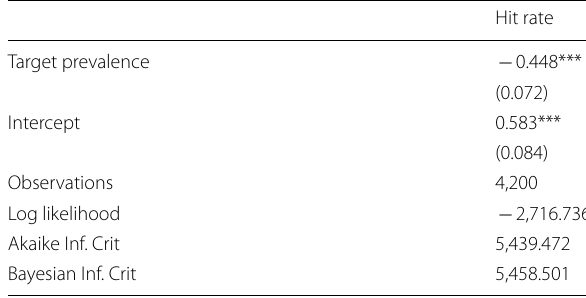
Table 3 Generalised linear mixed‑effects model comparing hit rate between high and low target prevalence categories in Experiment 2 (standard errors in